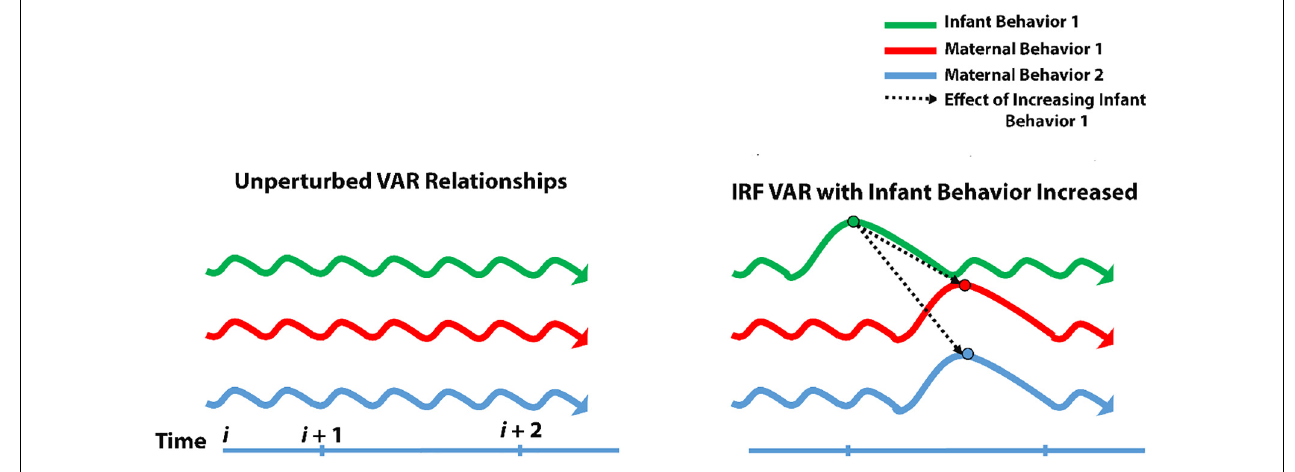
FIGURE 2 | Impulse-response modeling. Schematic of impulse-response modeling and how it serves to test for unique contributions of individual variables engaging in bidirectional